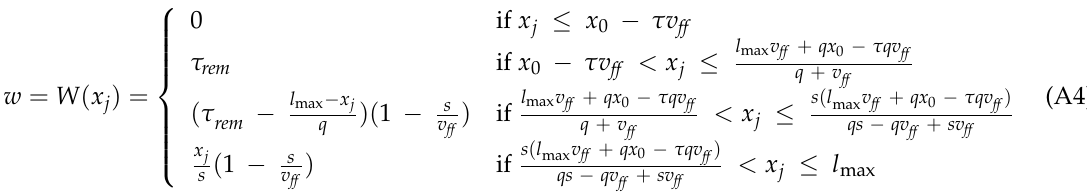
Figure A1 indicates a general diagram of Equation (A4).